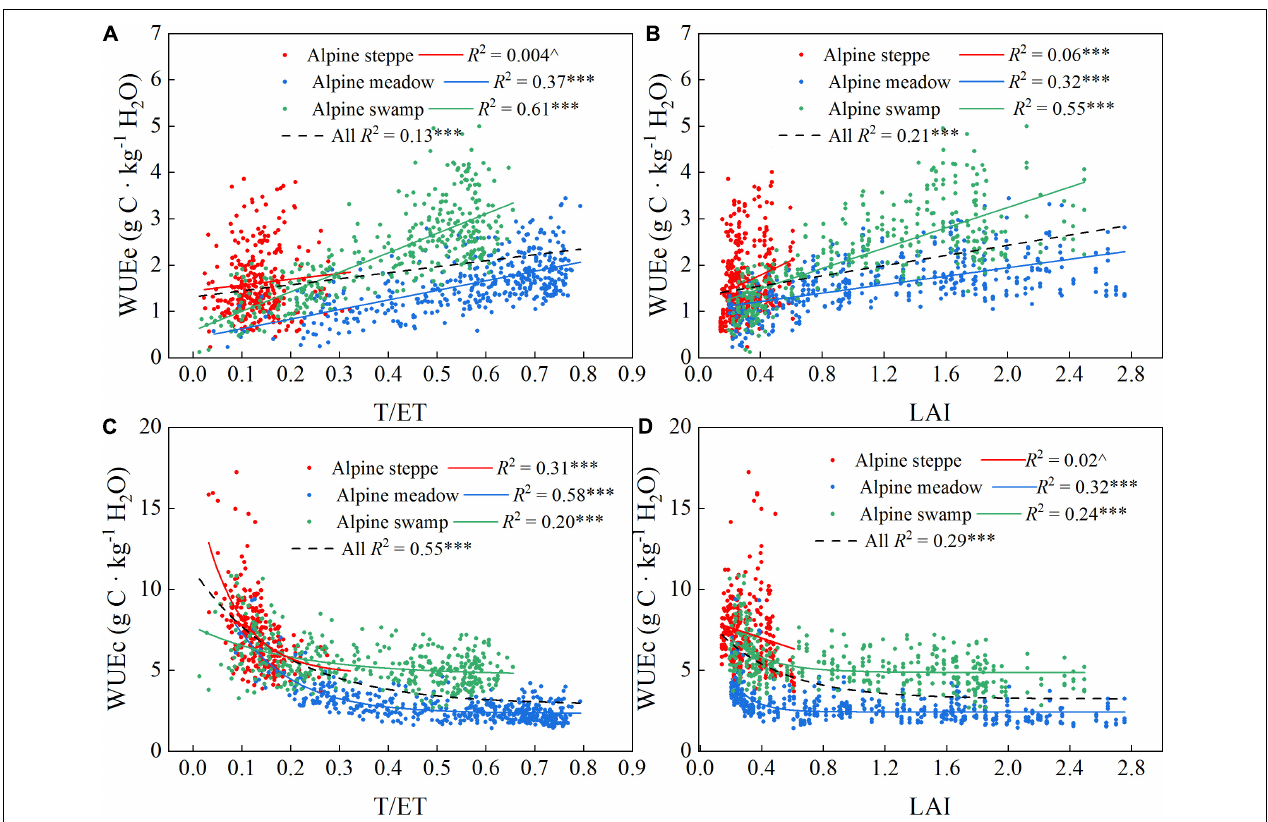
FIGURE 6 | Correlations between T/ET, LAI to WUEe (A,B) and T/ET, and LAI to WUEc (C,D) of the three alpine ecosystems. R 2 and probabilities of regressions are shown for each correlation. ˆ p > 0.05; ∗∗∗ p <